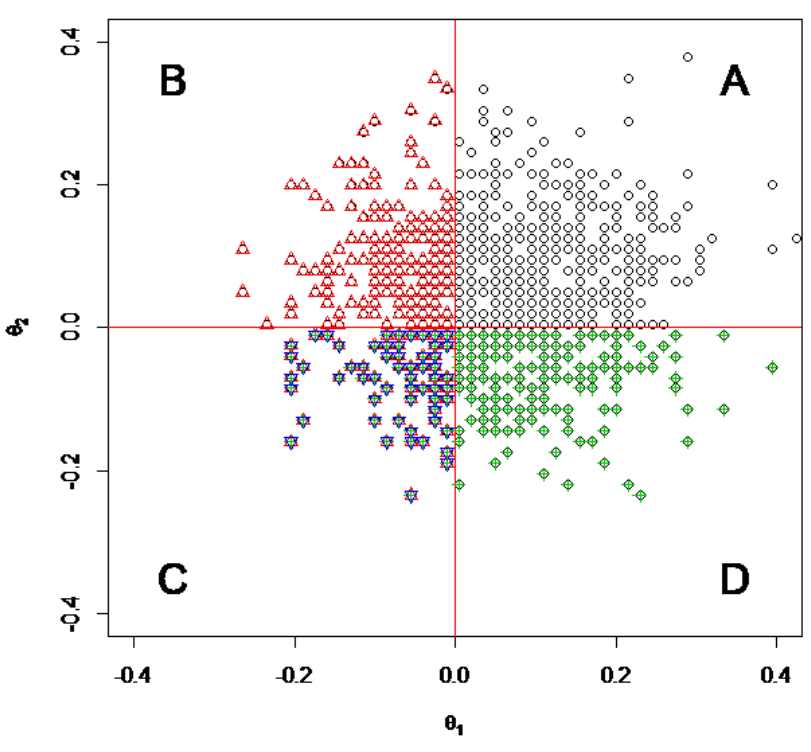
Figure 1. The scatter plot of 1000 MLEs of ˆ θ 1 and ˆ θ 2 for the case of n = 200 and θ 1 = θ 2 =